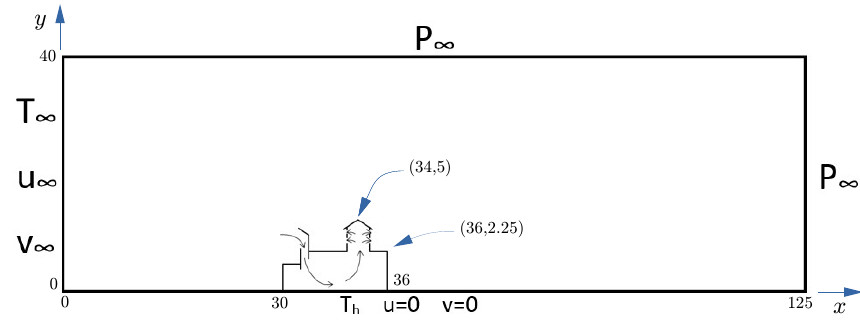
Figure 15. Wind tower problem